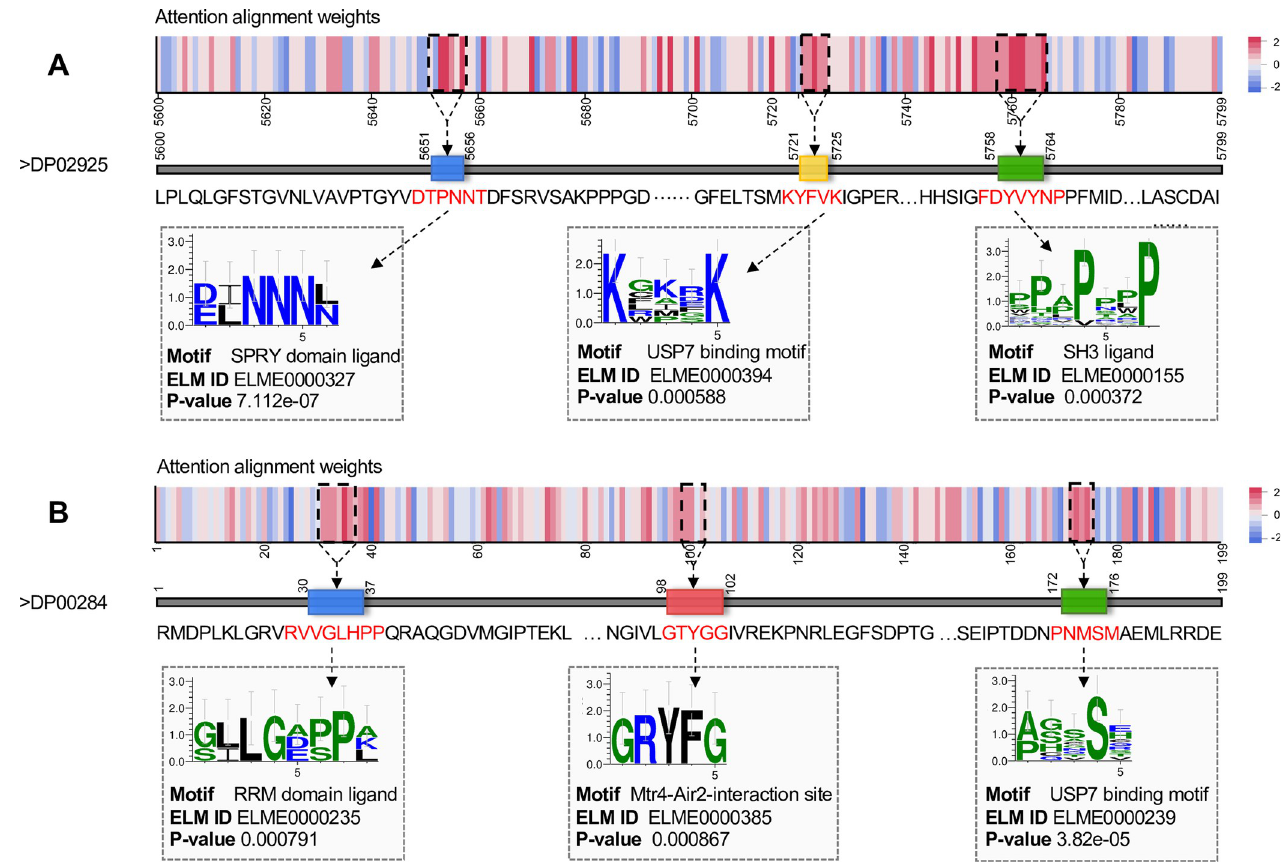
Fig 6. The attention alignment weight